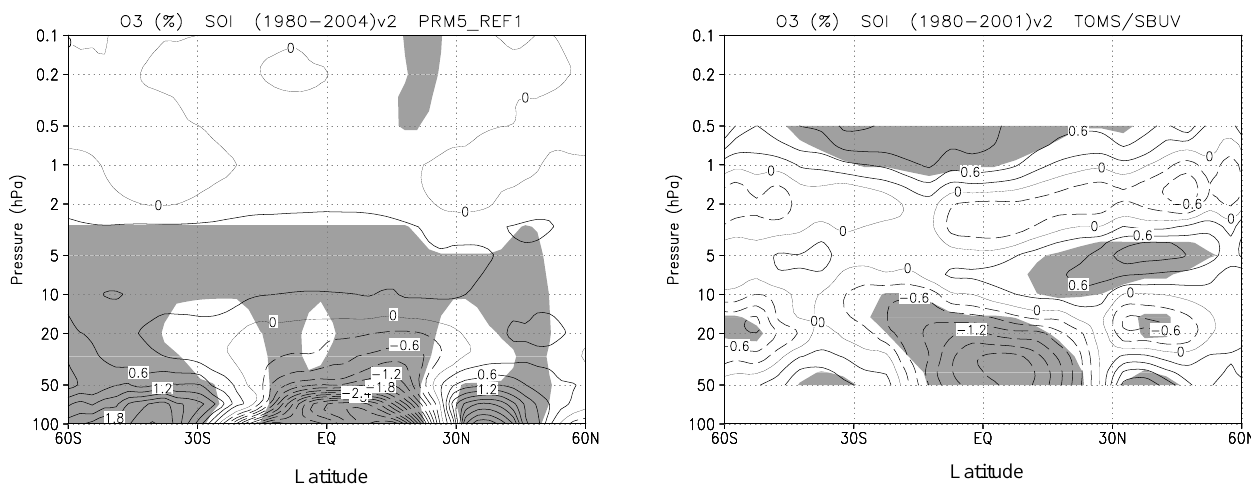
Latitude Latitude Fig. 22. Same as in Fig. 20 except for ozone in % with the observation being TOMS/SBUV, and contour interval is